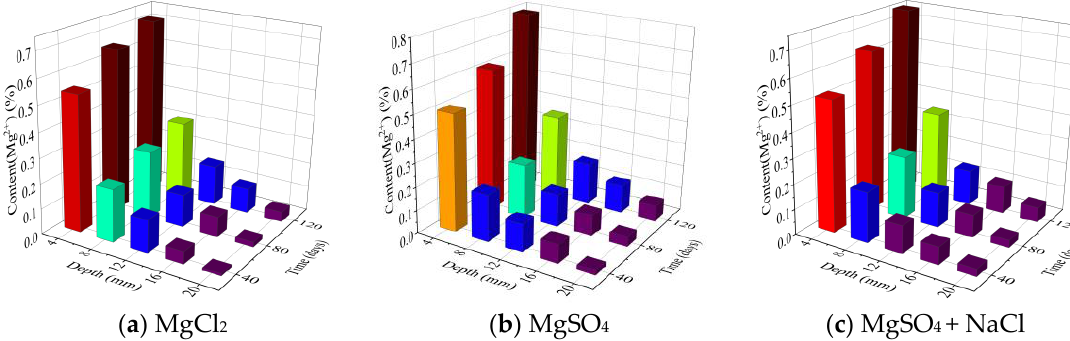
Figure 8. SO 4 2− Content in MK Concrete.